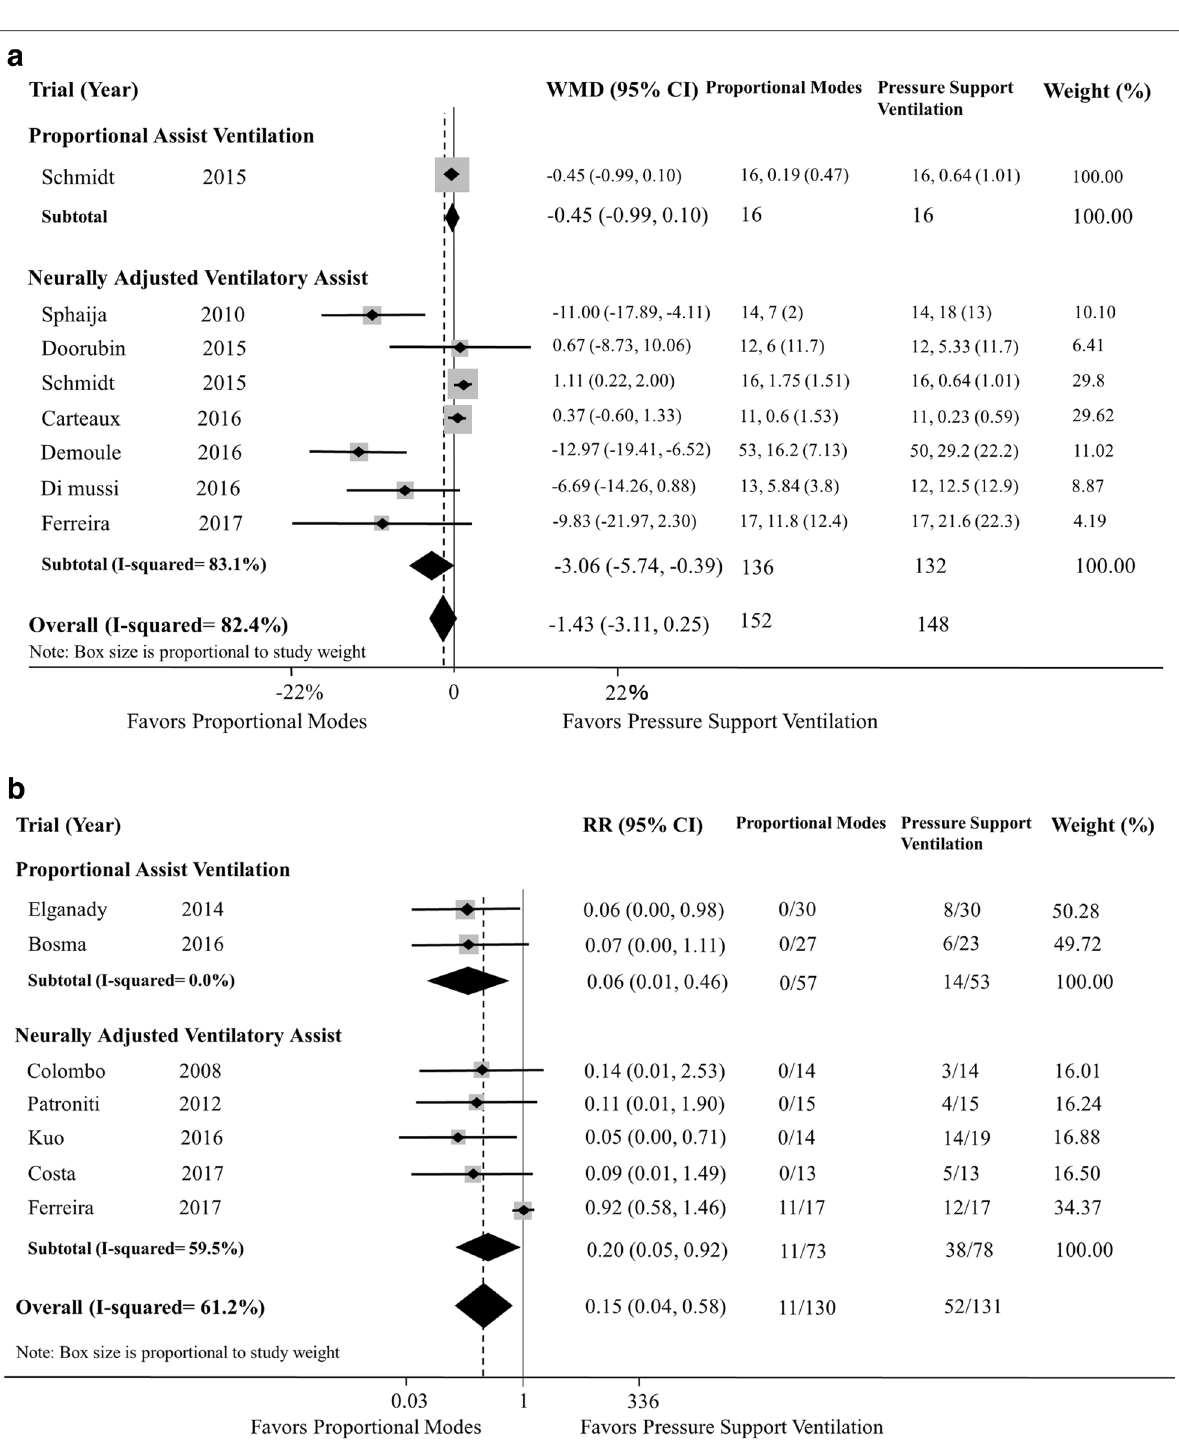
Fig. 2 Relative risk of asynchrony index (AI) in included studies ( a AI as a continuous outcome, b AI as dichotomous whenever the number of patients with AI > 10%). RR risk